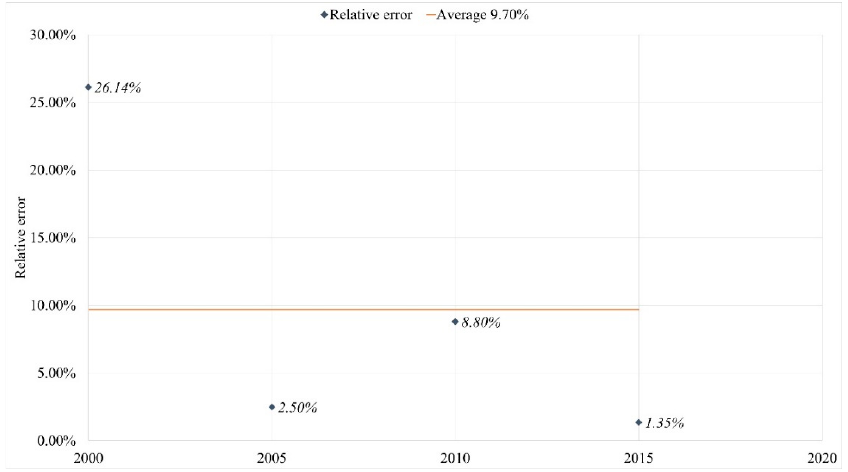
Figure 5. Relative errors of the estimated number of employees in the Pudong New Area. Figure 5 shows that the average error of population estimation for the four specific years is 9.70%, among which the errors of estimation for three years are less than the av- erage error, and the error of estimation for 2000 is higher than the average error, with a maximum error of 26.14%. The year with the largest error in population estimation is 2000, which is probably since the land allocation for the early industries in the Pudong New Area preceded the population inflow. 4.3. Limitations The limitations of this paper are as follows. (1) On the city scale, the characteristics and paths of city–industry integration will be different for cities with different natures and functions. As a comprehensive metropolis, the evaluation ideas and methods of city– industry integration in Shanghai may be different from those of small- and medium-sized specialized cities, which need to be further studied. (2) On the industrial park scale, the comparative study of different types of industrial parks needs to be further strengthened. In China, there are various industrial parks, economic and technological development zones, high-tech development zones, and export processing zones. Although their com- mon characteristics include obvious industrial advantages and a single function, espe- cially a weak social service function, there are still some differences among them. (3) There is no empirical study on the development mode of new cities or new towns (i.e., “city before production” mode), such as Songjiang New City and Anting New Town in Shang- hai, and there is no comparative analysis between the “production before city” mode and the “city before production” mode. This paper mainly focuses on the “production before city” mode, and it neglects the “city before production” mode. At present, Shanghai is carrying out the planning and construction of “five new cities” (Songjiang, Jiading, Qingpu, Fengxian, and Nanhui New Cities) [86], and the model of “city before produc- tion” exhibits great research potential, which also shows that the theory of city–industry integration development has broad application prospects. Improving the theoretical sys- tem and methodology of the city–industry integrated development through more empir- ical studies is an important academic goal for the future. 4.4. Policy Recommendations At the city scale, the policy focus of city–industry integrated development is (1) inte- grating high-quality housing, leisure, and recreational facilities into the commercial cen- ters and sub-centers; (2) building more office space, shopping space, and leisure and en- tertainment space close to homes along major traffic routes to reduce the need for